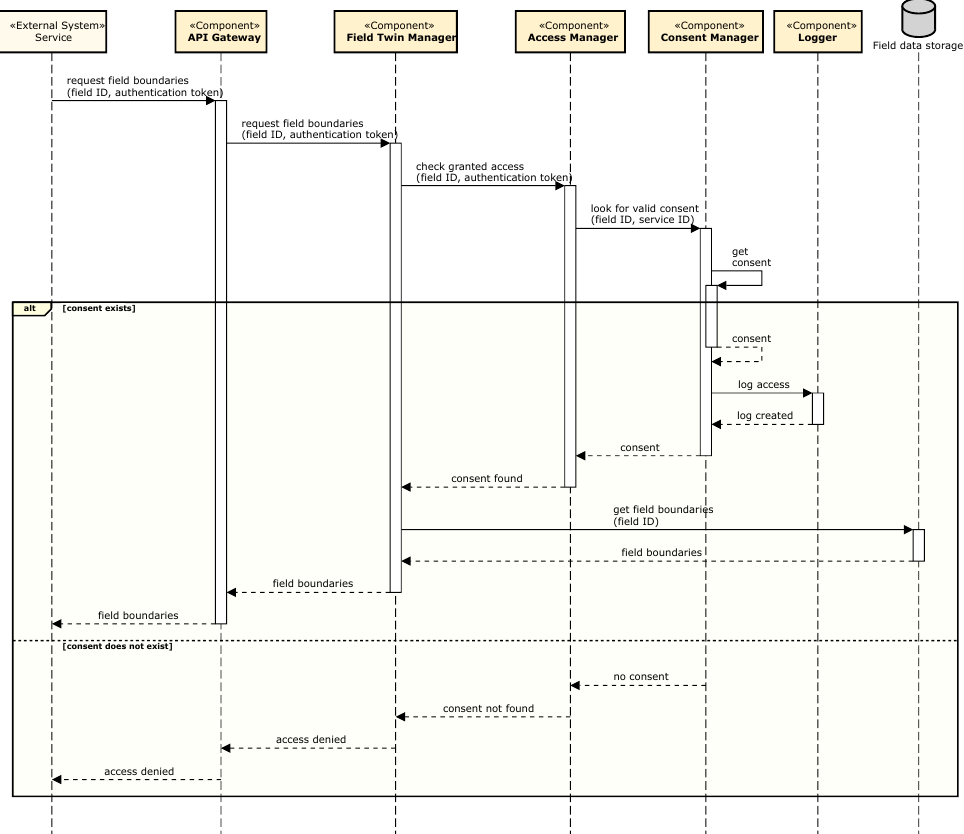
Figure 9. Sequence diagram of the logging process. First, a service requests the reading of the field boundaries of a certain field. The request reaches the Field Twin Manager through the Twin-Hub API. Next, the Field Twin Manager asks the Access Manager whether the access has been granted to the requester. Then the Access Manager checks with the Consent Manager whether there is valid consent for the request. After that, if there is valid consent, the Access Manager logs the access. Finally, the Field Twin Manager retrieves the field boundaries from the corresponding digital field twin and returns this data to the